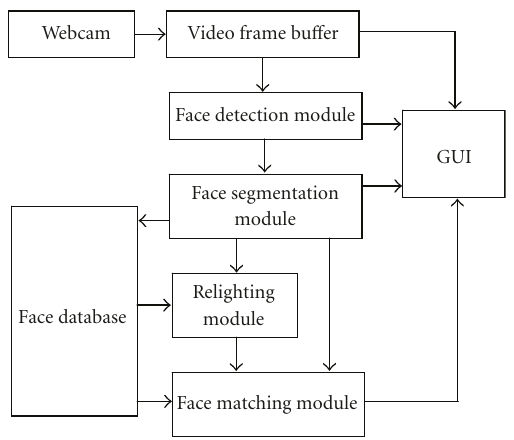
Figure 2: Overall system